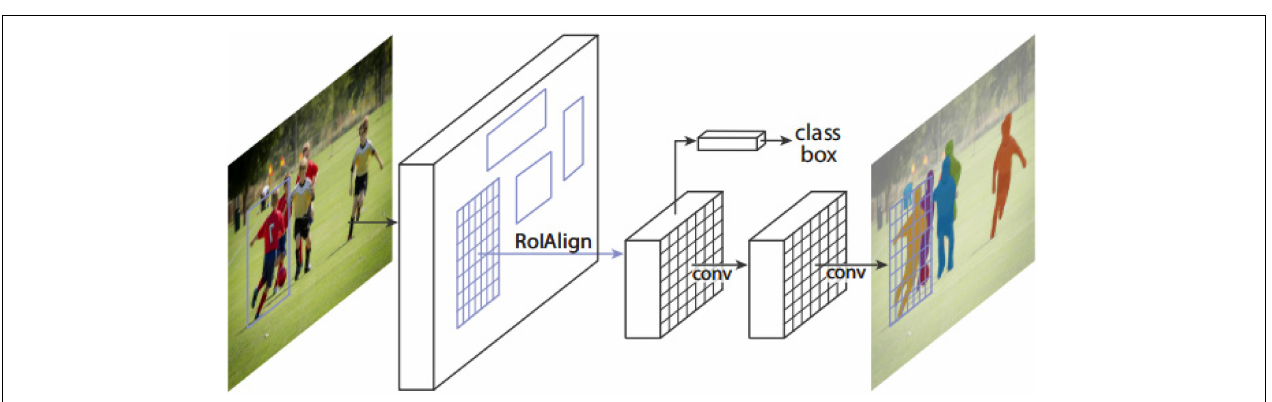
FIGURE 3 | The Mask R-CNN framework for instance segmentation (He et al., 2017).